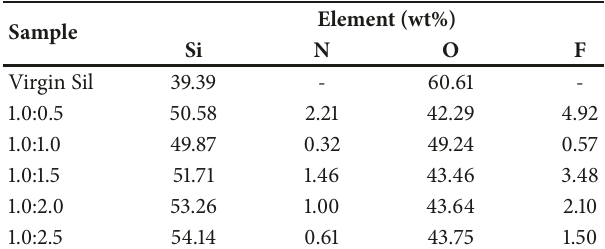
Table 2: Elemental composition of virgin silica and ionic liquid modified silica particles.